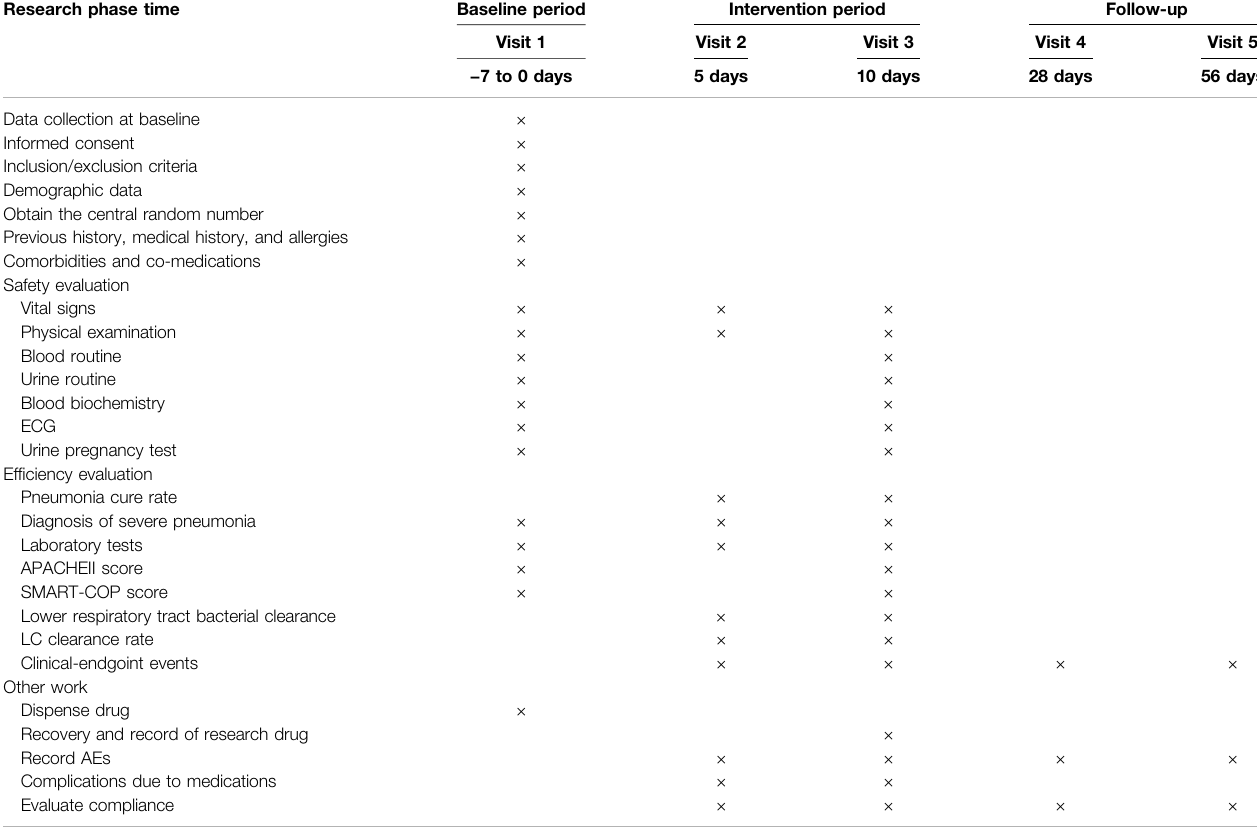
TABLE 2 | Research